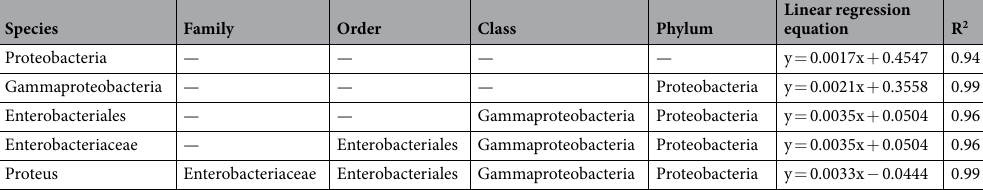
Table 2. The classification and linear regression equation of species which have significant correlation between relative abundance with PMI change. The y represents PMI (hr) and x represents the relative abundance (%) of